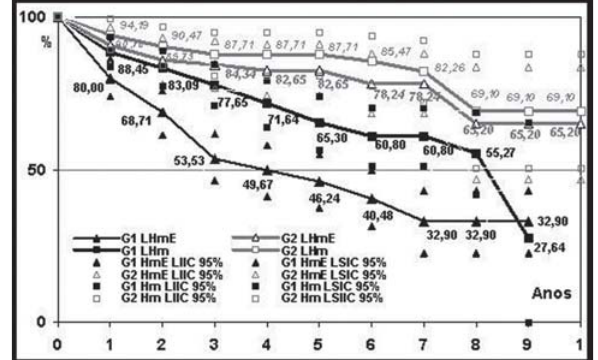
Fig. 7 - Curvas atuariais e pontos de limites superior e inferior do intervalo de confiança de 95%, de acordo com os conjuntos